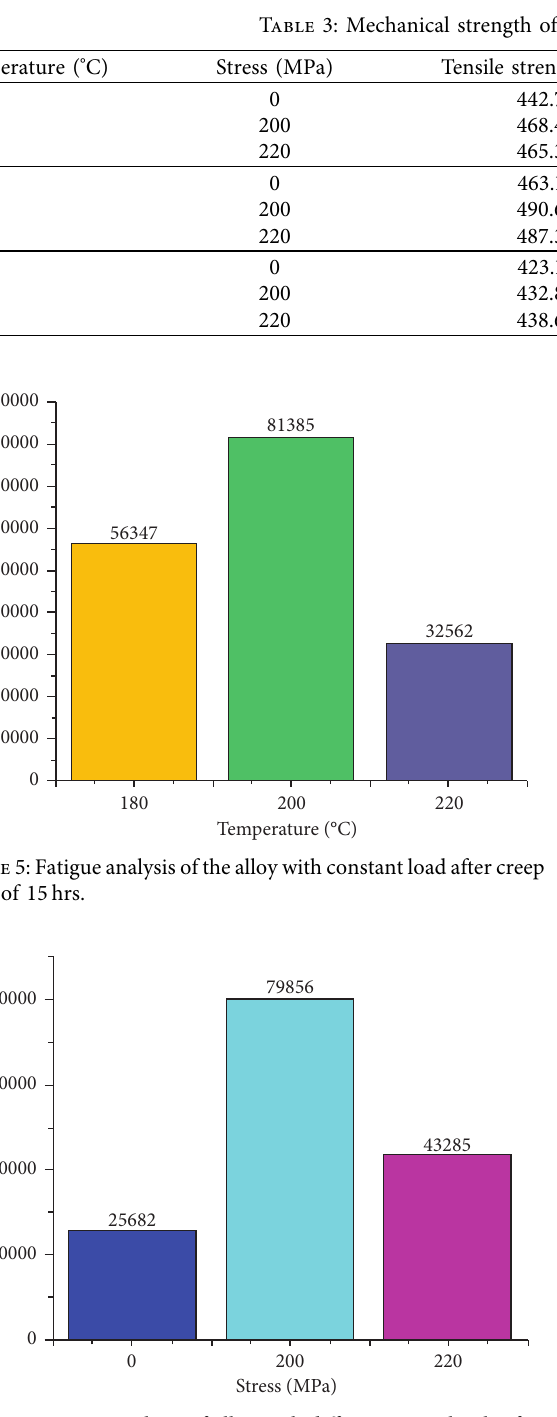
Figure 6: Fatigue analysis of alloy with different stress levels after creep aging of